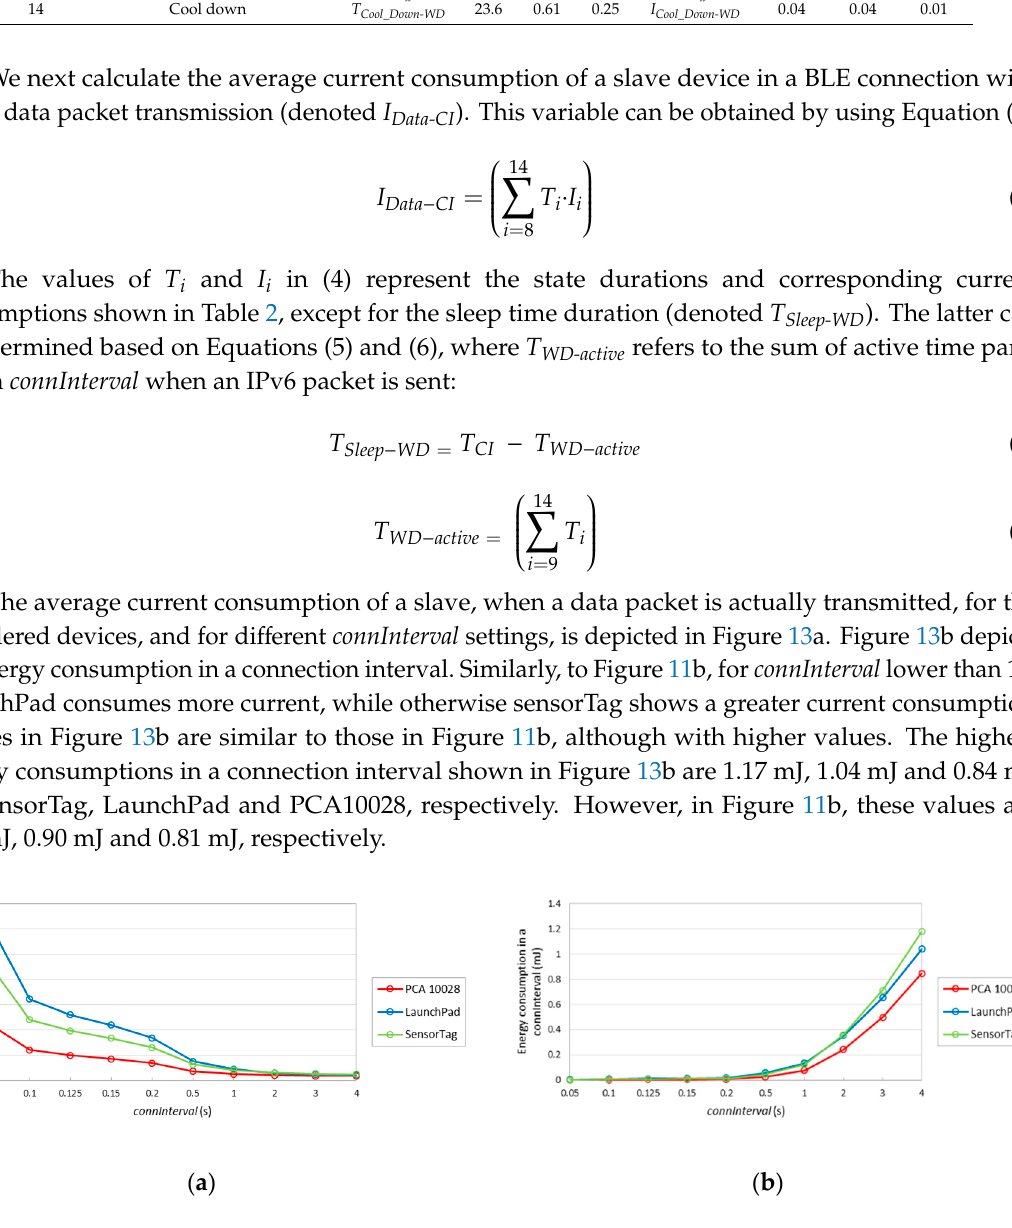
Figure 13. ( a ) Average current consumption for different connInterval settings, with data packet transmission; ( b ) energy consumption during a connection interval, with data packet transmission.